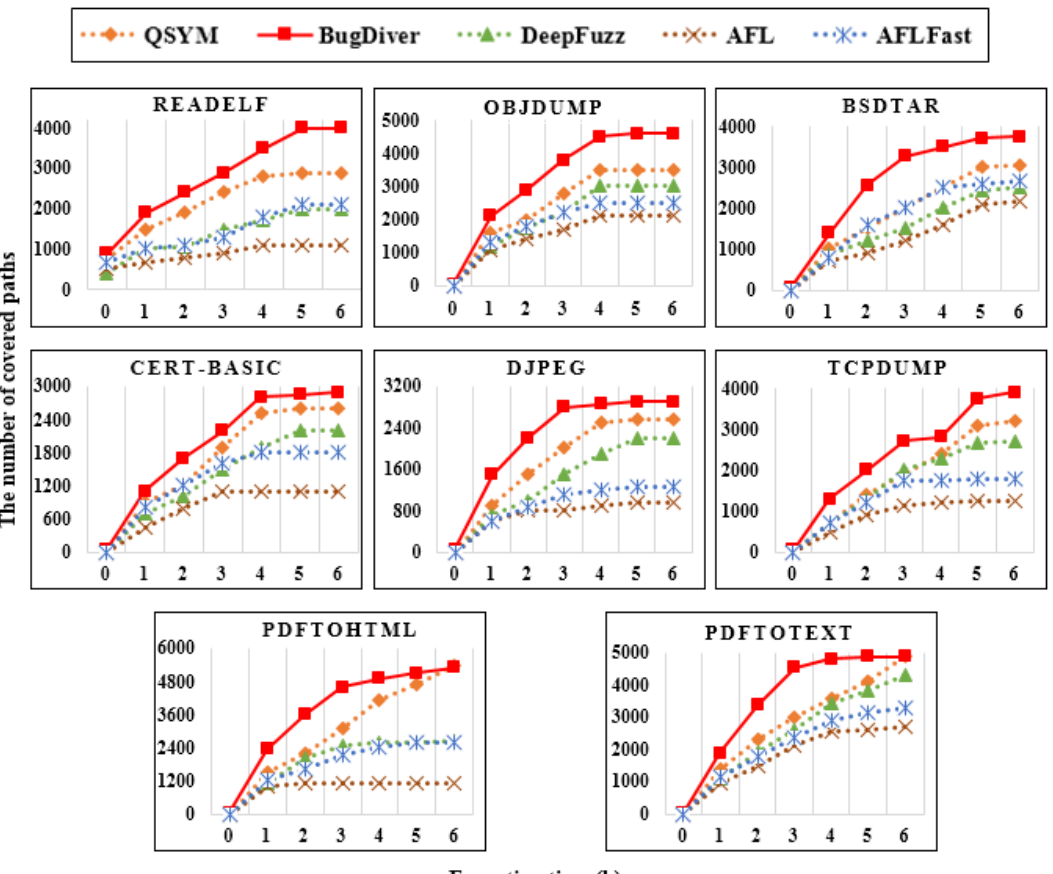
Figure 5. Number of covered paths in the real-world